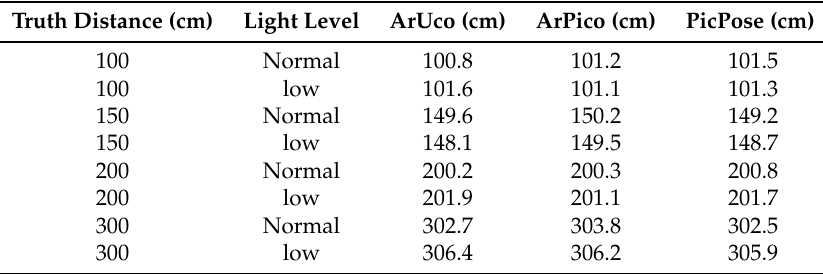
Table 3. Reported Pose Distance.